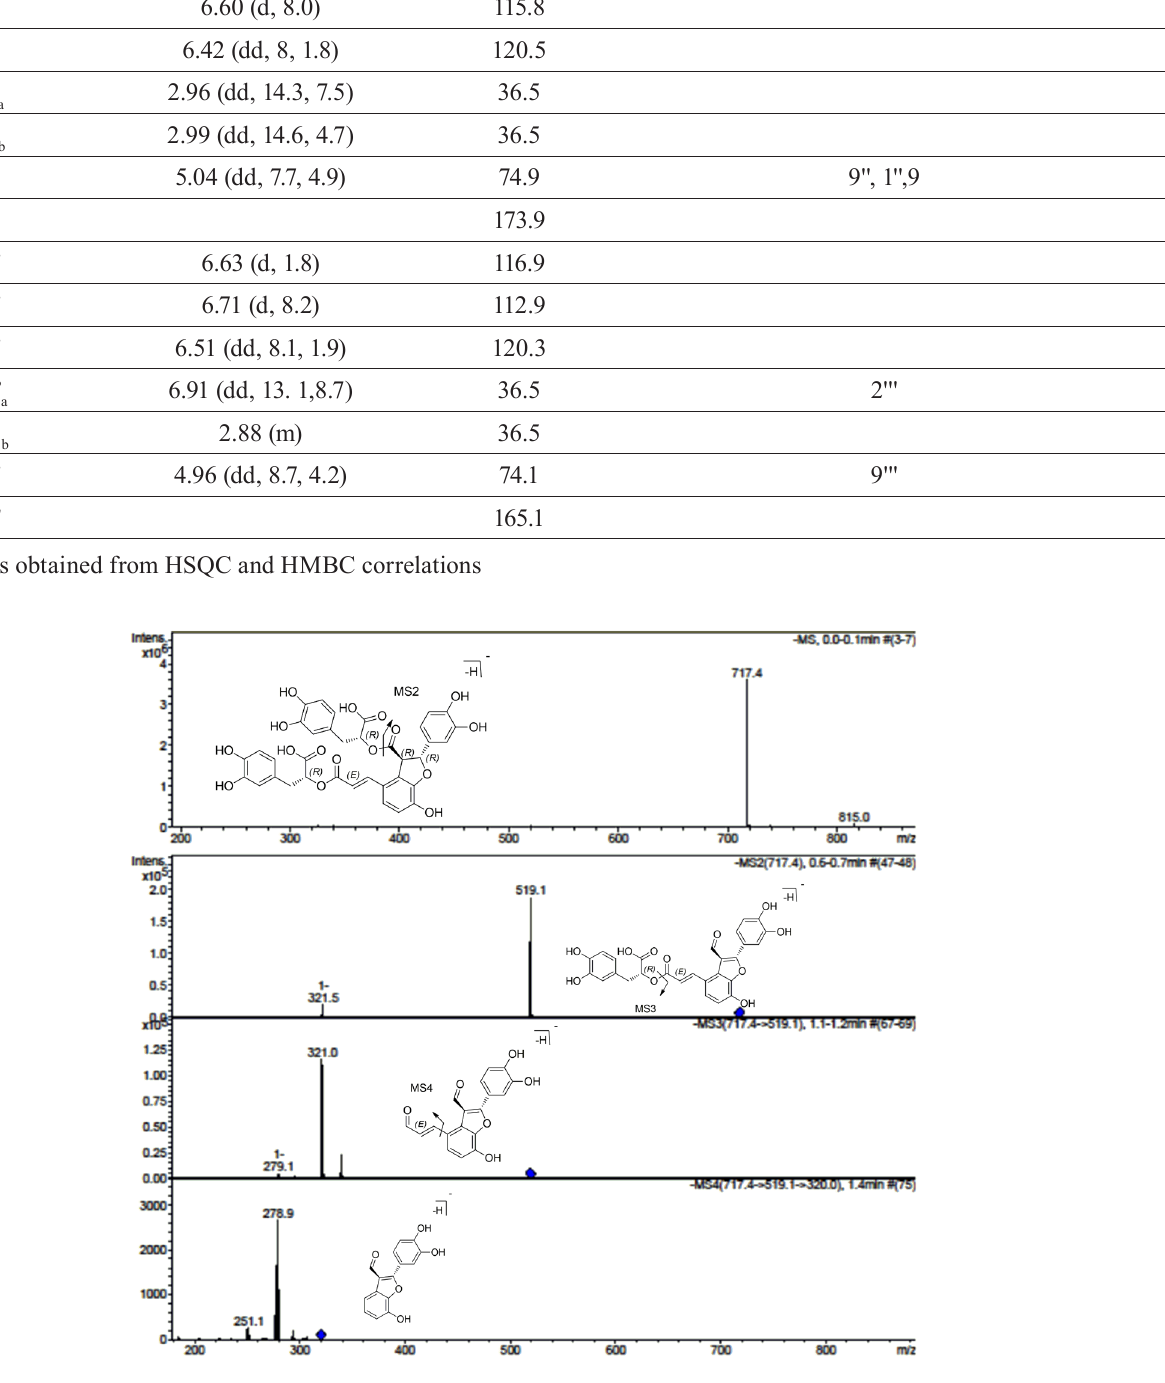
TABLE II - 1 H and 13 C NMR data (500 and 125 MHz, in CD position